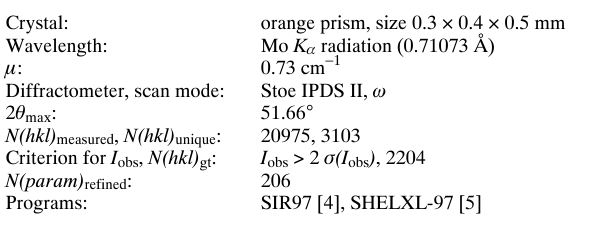
Table 1. D a t a collection a nd h a ndling.